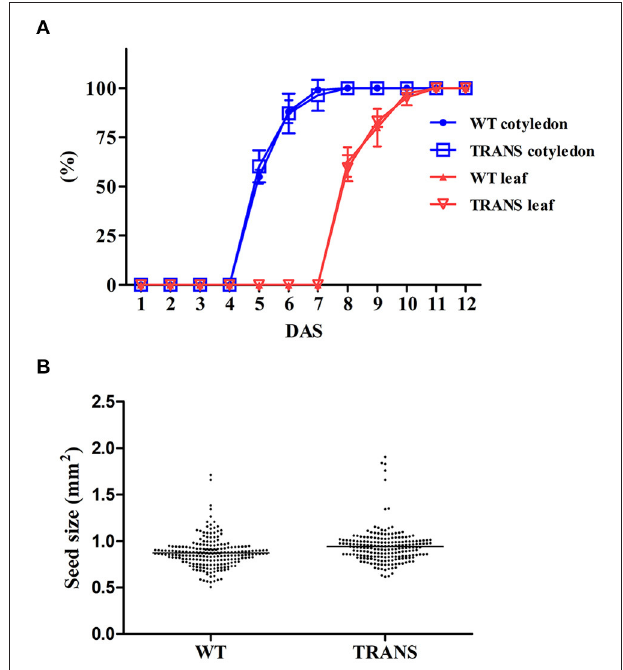
FIGURE 7 | Transplastomic expression of NifH and NifM does not cause pleiotropic effects. (A) Germination of NifH-expressing transplastomic tobacco plants. Seed germination (blue line) and seedling development (red line) of wild type (WT) and transplastomic (TRANS) plants. Germination was determined by cotyledon emergence (cotyledon) and seedling growth (leaf) by the emergence and elongation of the first leaves. Data represent average values ± SD of three independent experiments using seeds harvested from different batches of plants. DAS; days after sowing. (B) Seed size from four different plants were photographed using a Leica M165FC microscope and calculated using ImageJ software (version 1.48v). Tobacco wild type (WT) seeds were used as control. The size (mm 2 ) of seeds harvested from WT (0.89 ± 0.17) and transplastomic (0.94 ± 0.21) tobacco plants did not display statistically significant differences (Student’s t